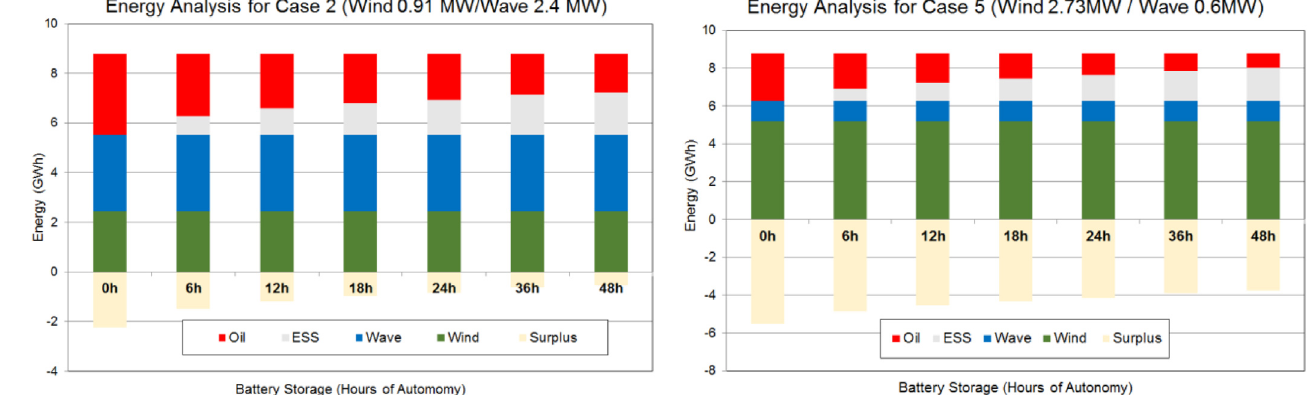
Fig. 14. Proposed solution energy analysis for case 5.